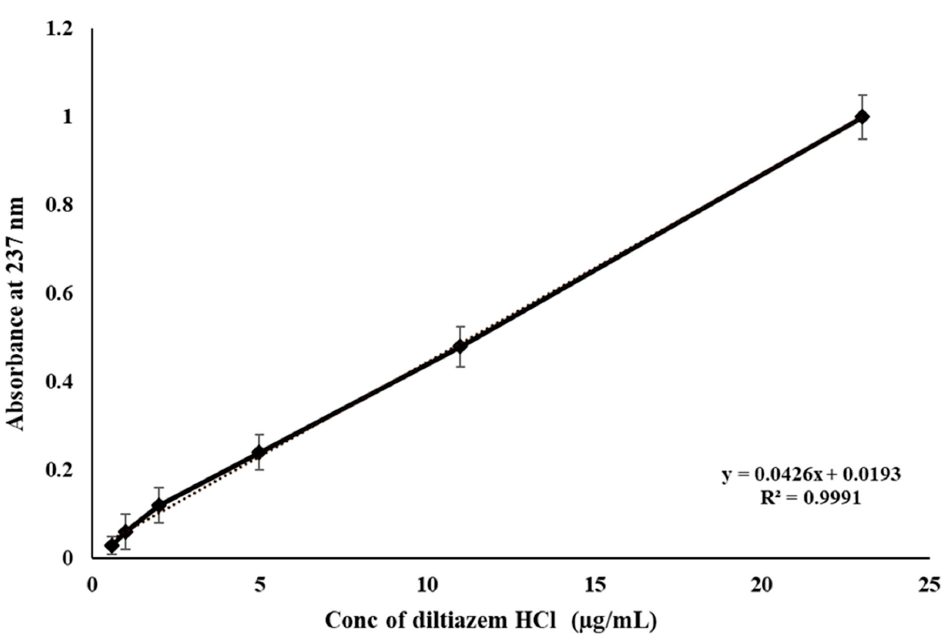
Figure 1. DLZ calibration curve in distilled water at 37 °C, ( n = 6), values are means ± S.D. ( n = 6).